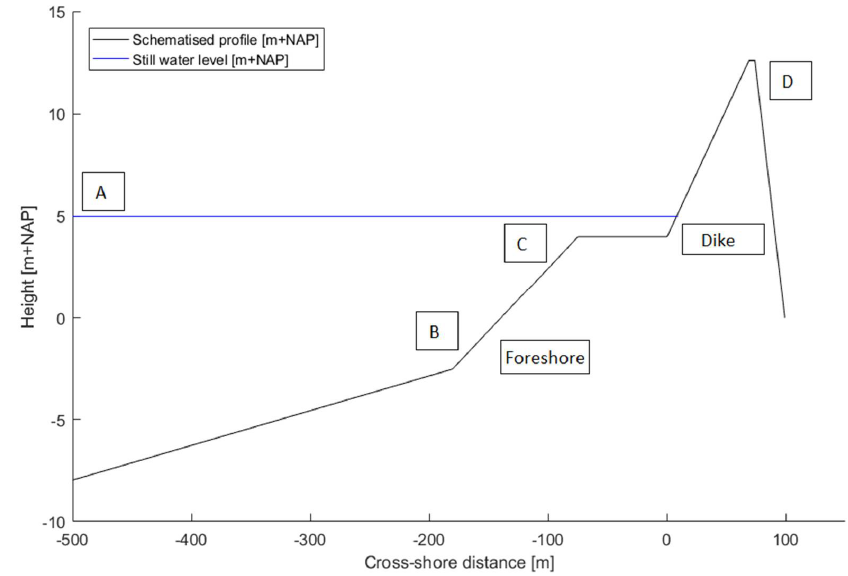
Figure 5. The cross-shore profile, with the locations where the stochastic variables of Table 1 act on, indicated by their tags. Note that only the section between −500 m and 100 m is shown.